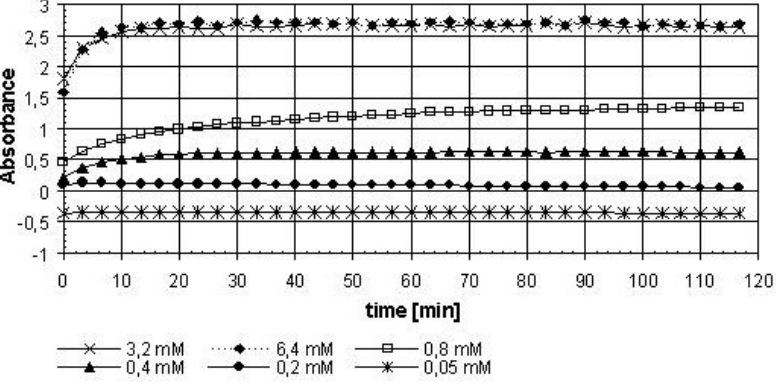
Figure 1. Kinetics of the enzymatic reaction for samples of different concentrations of the cofactor (0.2 - 6.4 mM) and a constant concentration of substrate (0.01 M) and enzyme activity (2 U/200 µl). Background buffer solution: glycine (176 mM of pH